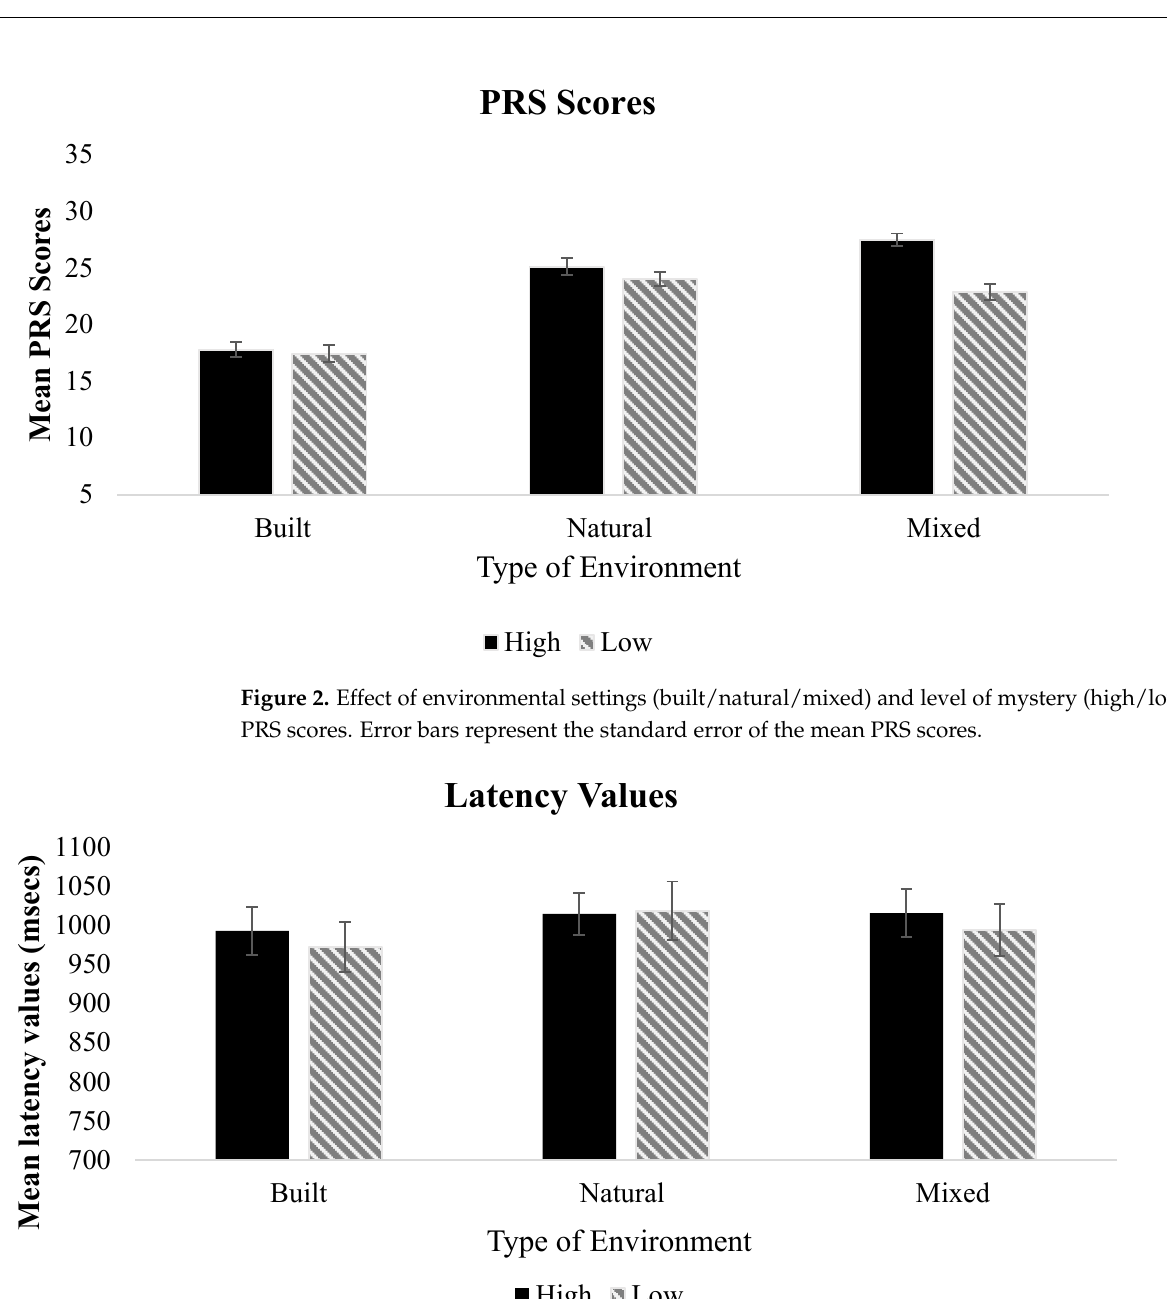
Figure 3. Effect of environmental settings (built/natural/mixed) and level of mystery (high/low) on latency values in the DSST. Error bars represent the standard error of the mean latency values.